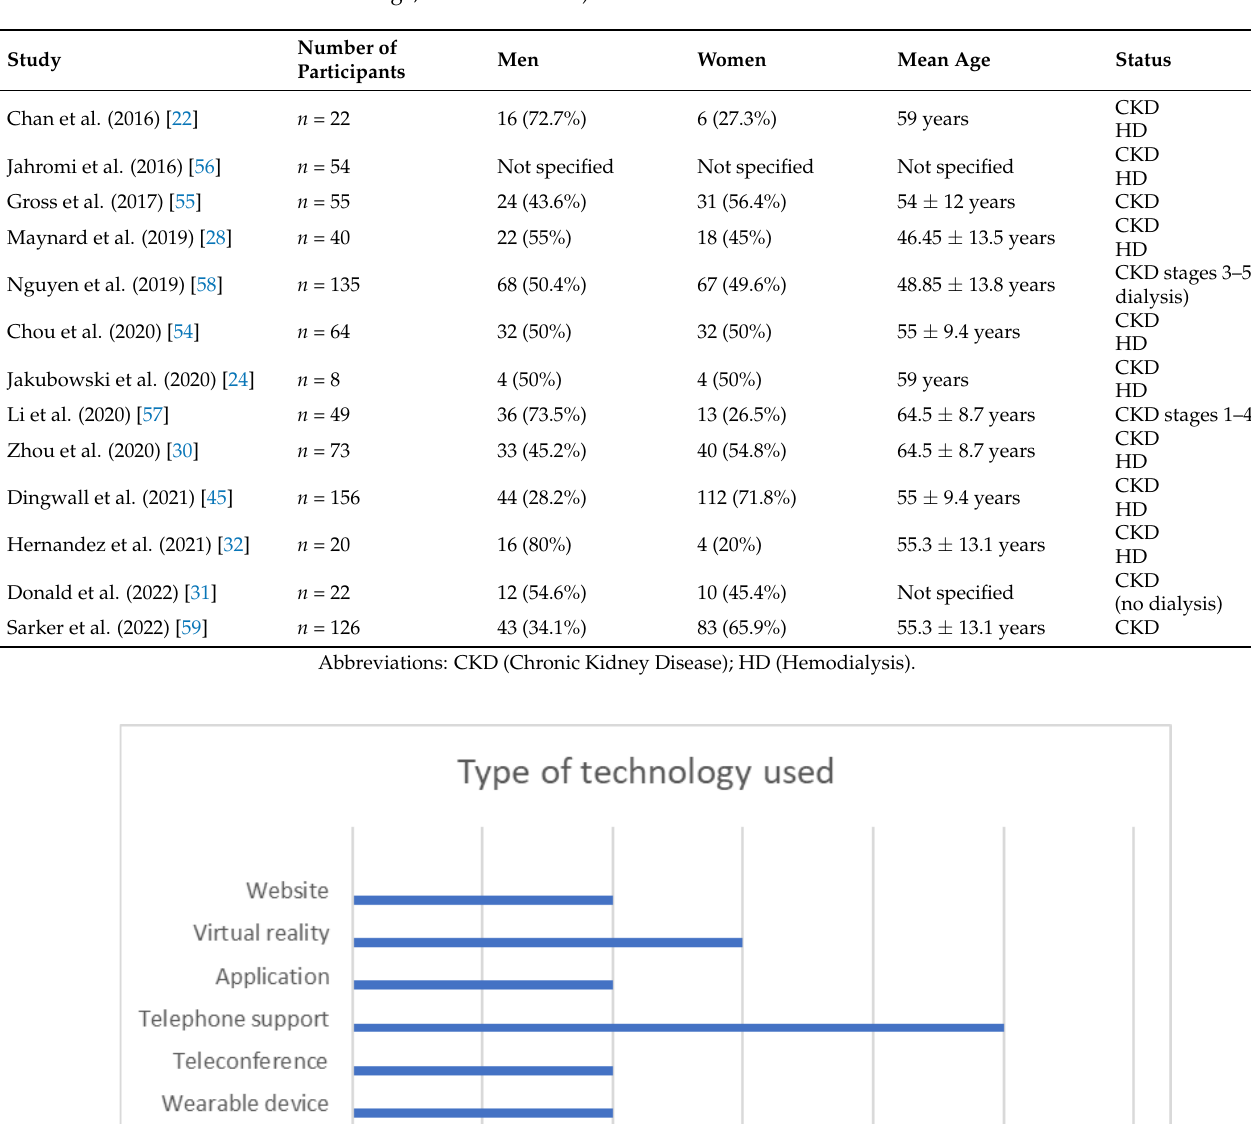
Table 2. Sociodemographic characteristics of participants per study (number of participants, sex, mean age, and CKD status).